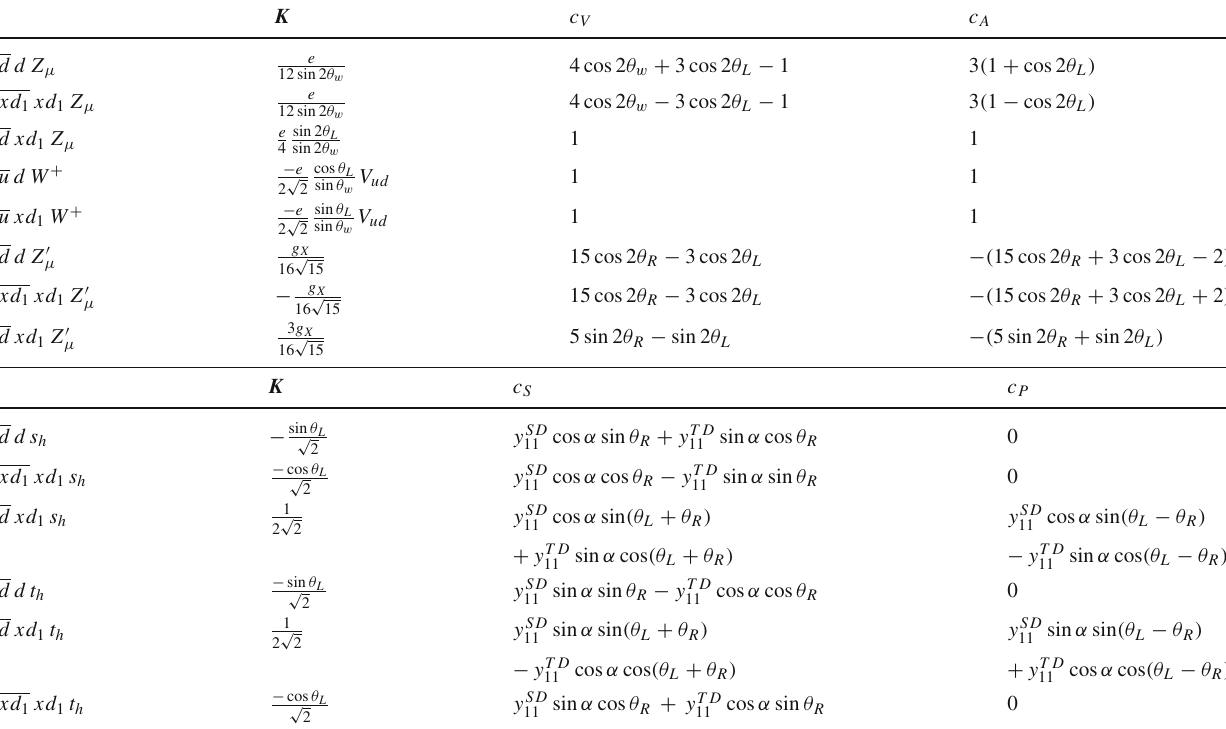
Table3 ThecouplingsofVLQ xd 1 and d -quarkwithSMgaugebosons Here α is the scalar sector mixing angle in Eq. (18), θ L and θ R are left and, with the scalars s h and t h . Coupling with gauge bosons are of the and right mixing angles in Eq. (29) form K γ μ ( c V − c A γ 5 ) and with scalars are of the form K ( c S − c P γ 5 ) . K c